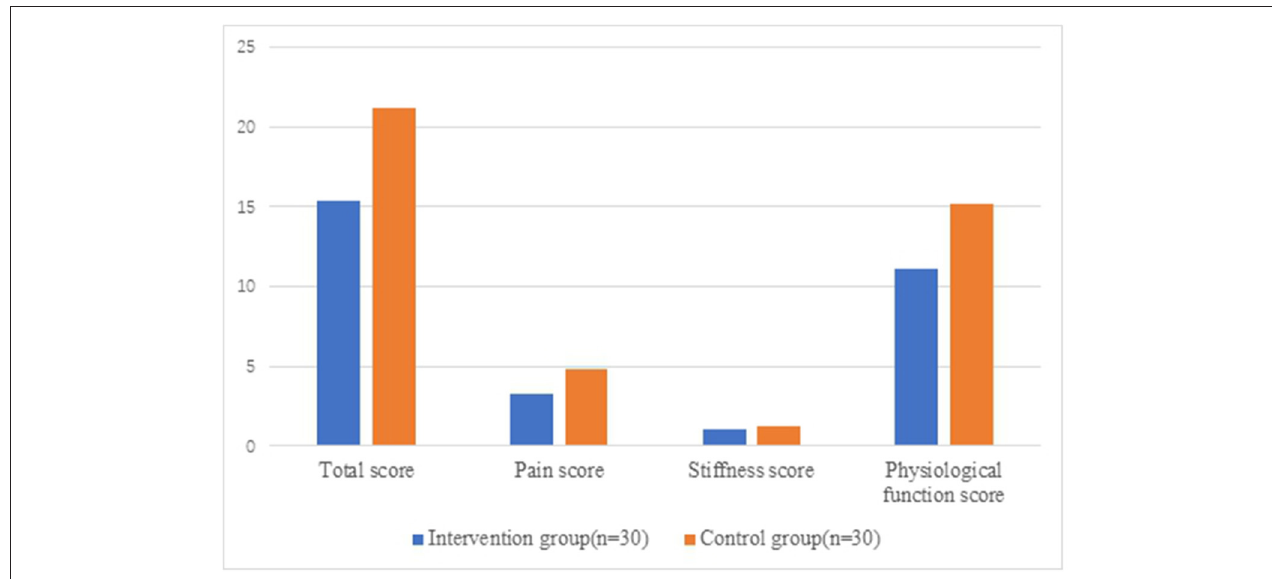
FIGURE 3 | WOMAC score measure between groups post-intervention. WOMAC, Western Ontario and McMaster Universities Osteoarthritis